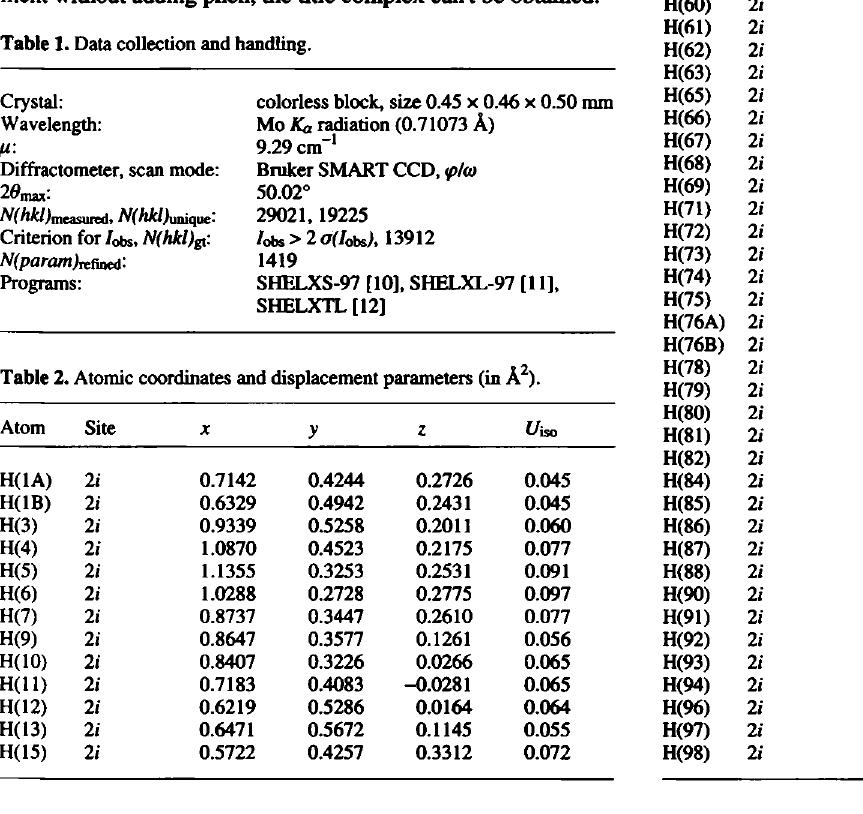
Table 1. Data collection and handling.